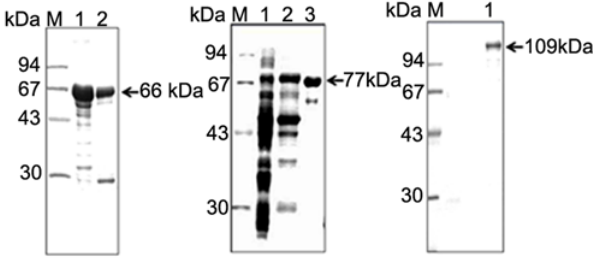
Figure 3. Expression of the recombinant protein. Recombinant proteins containing the LKR domain, SDH domain and full length LKR/ SDH were resolved by 12% SDS-PAGE. A, lane 1, protein extracts from induced E. coli carrying pGEX-4T-3/LKR; lane 2, purified GST/LKR fusion protein; B, lane 1, lysate of E. coli without pGEX-4T-3; lane 2, protein extracts from induced E. coli carrying pGEX-4T-3/SDH; lane 3, purified GST/SDH fusion protein. C, lane 1, purified recombinant His-LKR/SDH protein; M, molecular weight marker.